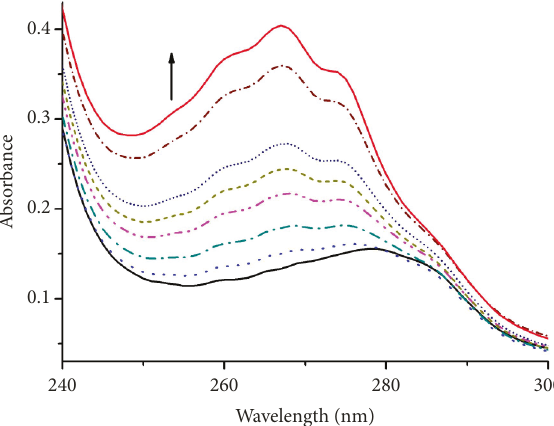
Figure 4: Electronic absorption spectra of HSA (3.0 μ M) in the presence of different concentrations of DBPP (0.0, 3.0, 6.0, 12.0, 18.0, 24.0, 30.0, and 48.0 μ M). The arrow shows the direction of change in absorbance upon increasing the concentrations of DBPP.